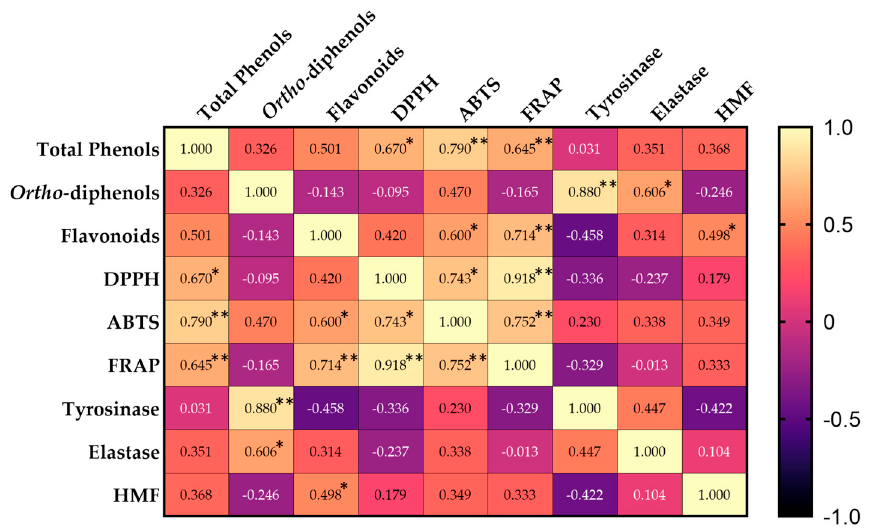
Figure 2. Pearson correlation between phenolic content, antioxidant capacity, anti-aging capacity, and HMF content. Significance: * significant at p < 0.05; ** significant at p < 0.01; *** significant at p < 0.001.